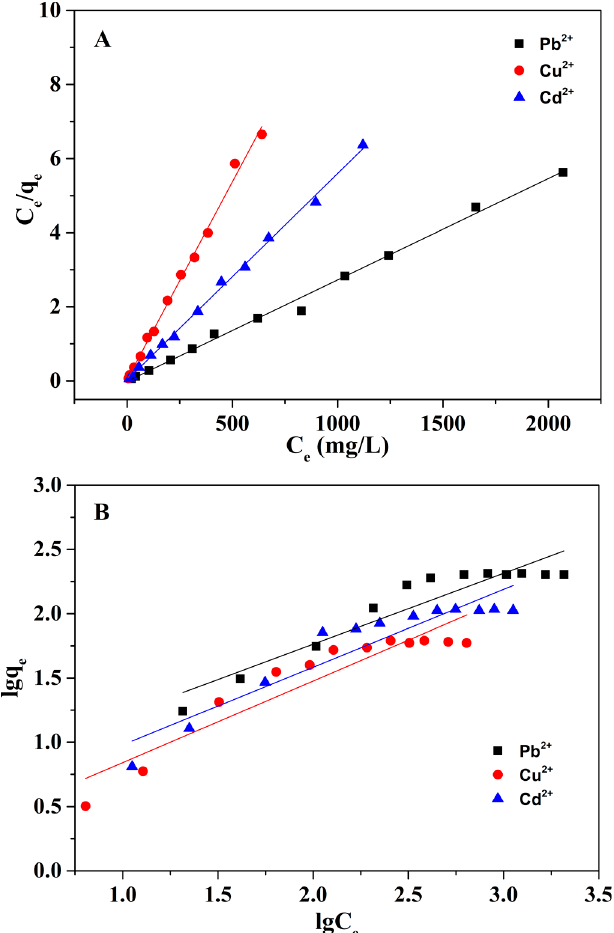
Figure 8. ( A ) Langmuir and ( B ) Freundlich adsorption isotherms studies of the Pb 2+ , Cd 2+ , and Cu 2+ . (~50 mg of mp-CA/GO was equilibrated with 50 mL of Pb 2+ , Cu 2+ , or Cd 2+ solution at 25 °C for 40 min). Table 3. Isotherm parameters for Pb 2+ , Cd 2+ , and Cu 2+ ions adsorption on the mp-CA/GO. Isotherm Model Formula